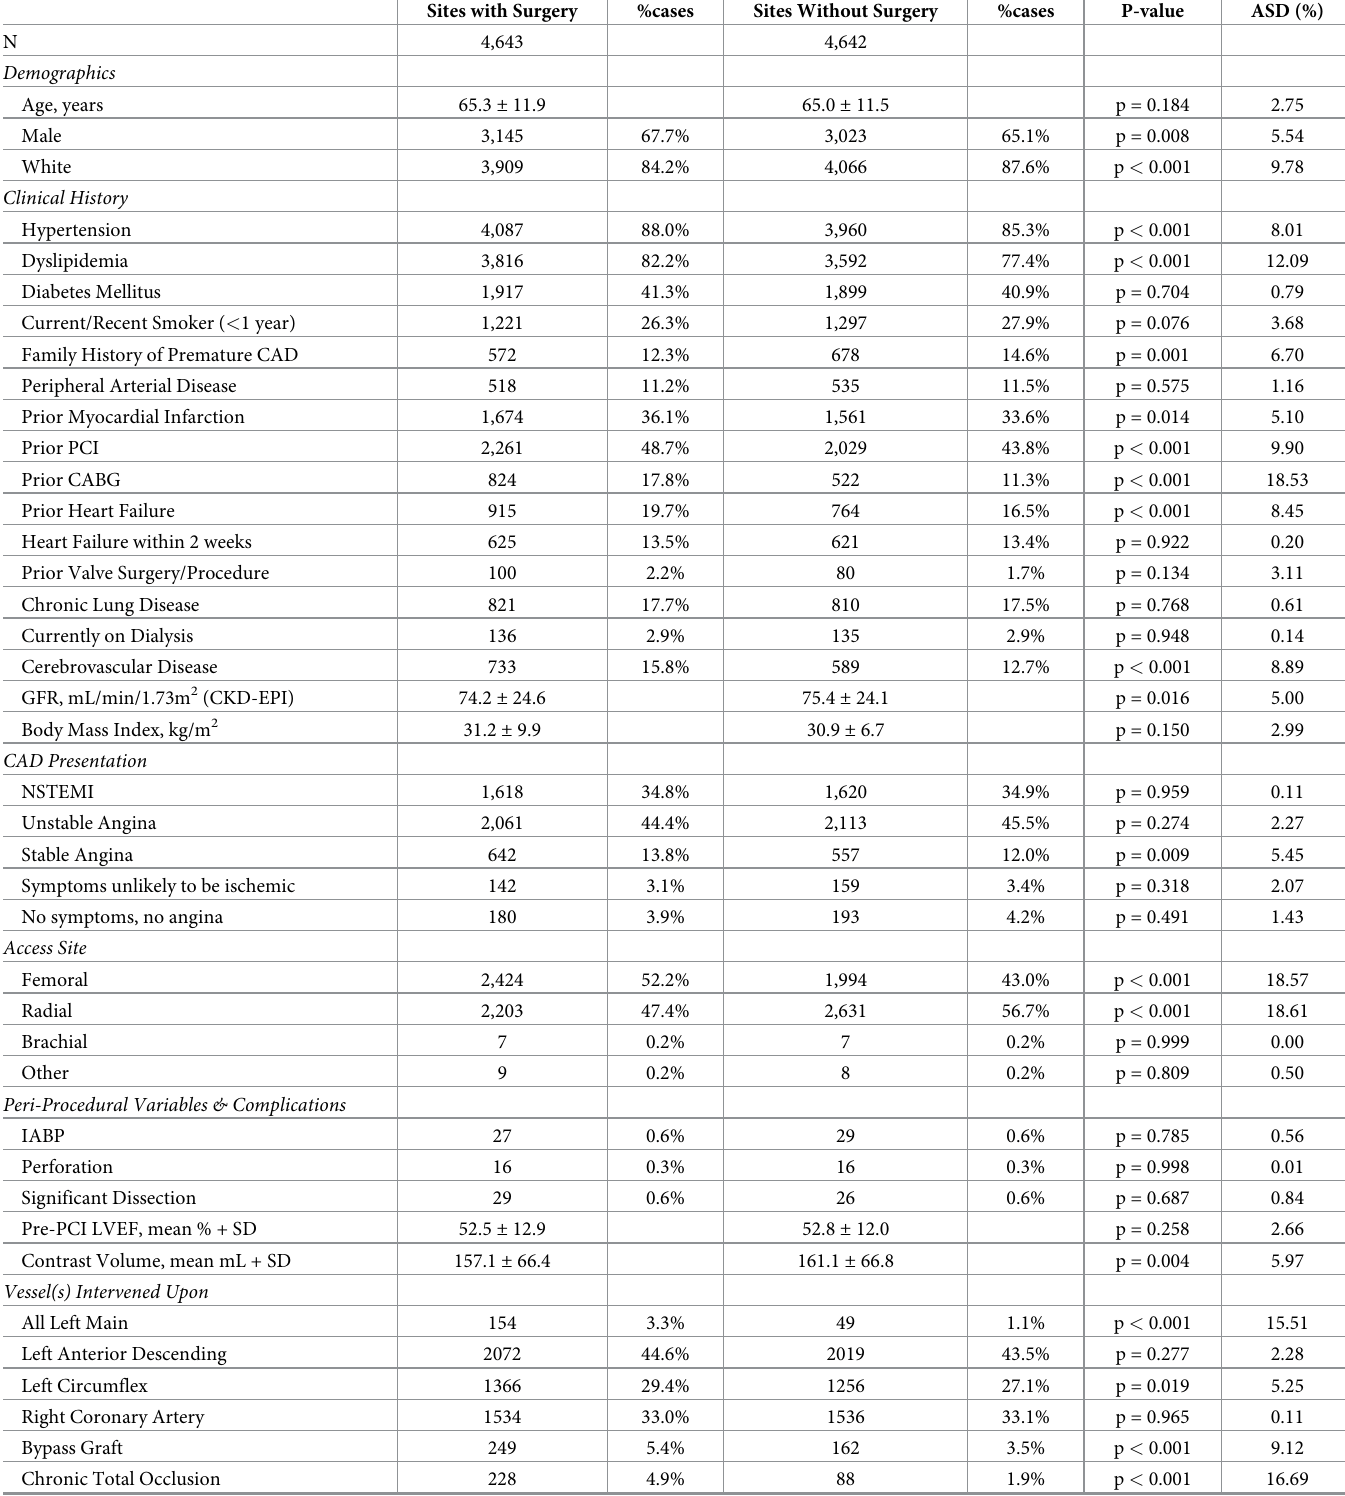
Table 1. Baseline characteristics of propensity-matched cohorts of elective PCI’s performed during study